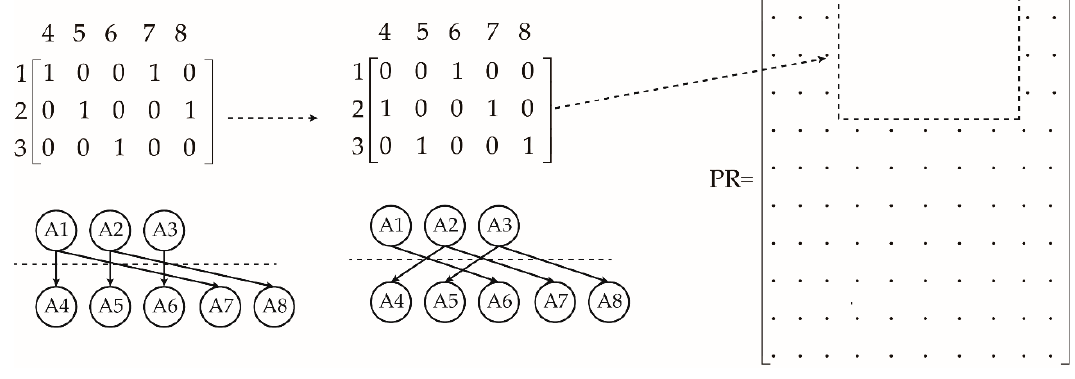
Figure 6. Diagram of the test case generation process.